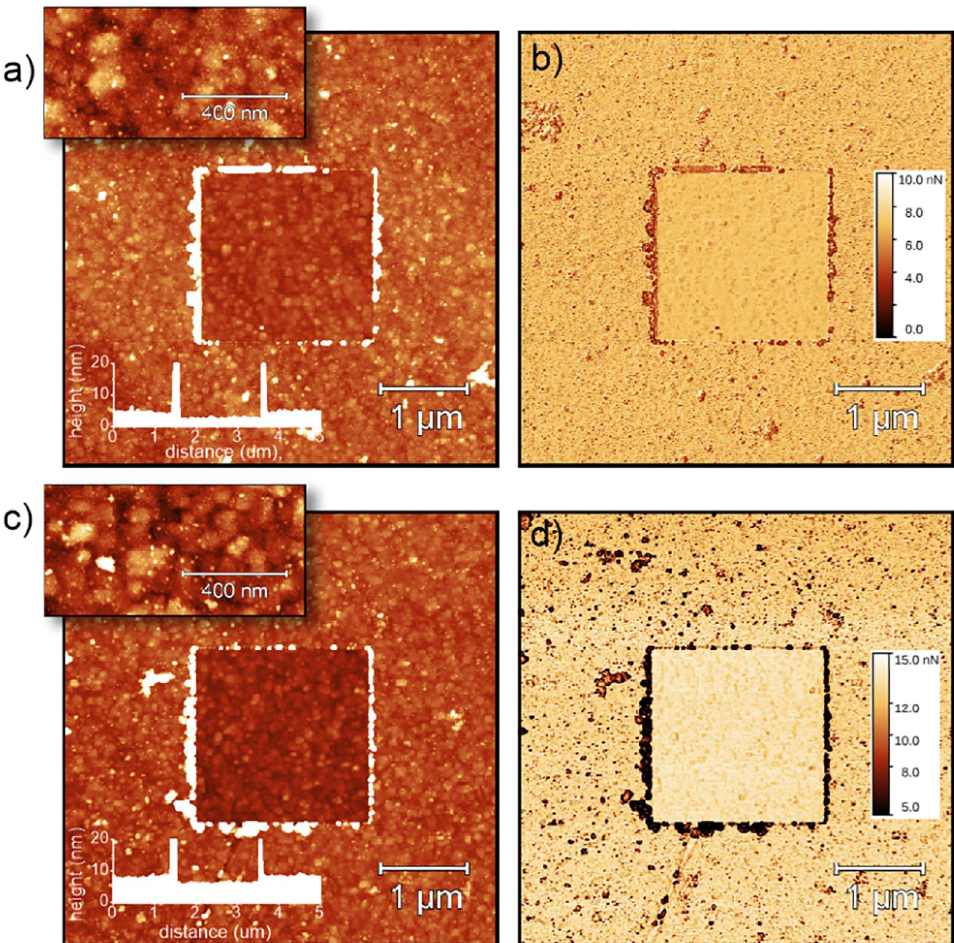
Figure 2. BMP-7 morphology ( a,c ), adhesion maps (b,d) , and thickness profiles (insets) observed by AFM in the PFQNM regime on oxidized ( a,b ) and hydrogenated ( c,d ) NCD surfaces. The square in the centre corresponds to the area from which the molecules were removed (nanoshaved) by scanning in contact mode AFM. The Z scale is 20 nm for 5 × 5 µm 2 topography images, 10 nm for 0.5 × 1 µm 2 topography images (insets) and 10 nN for 5 × 5 µm 2 adhesion